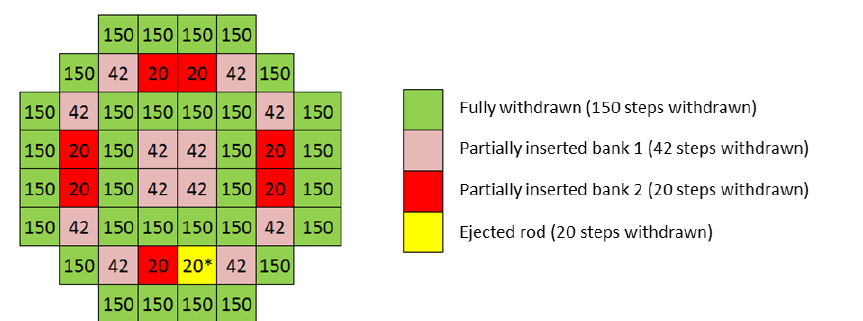
Figure 2: Initial control rod insertion prior to the transient for the small SBF PWR, with the active length of a fuel rod equivalent to 150